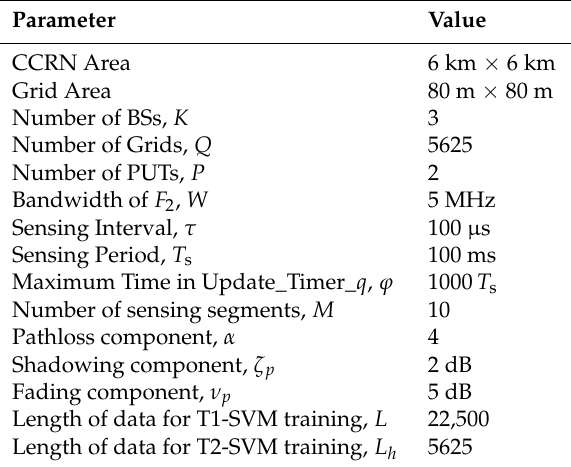
Table 4. Simulation parameters.